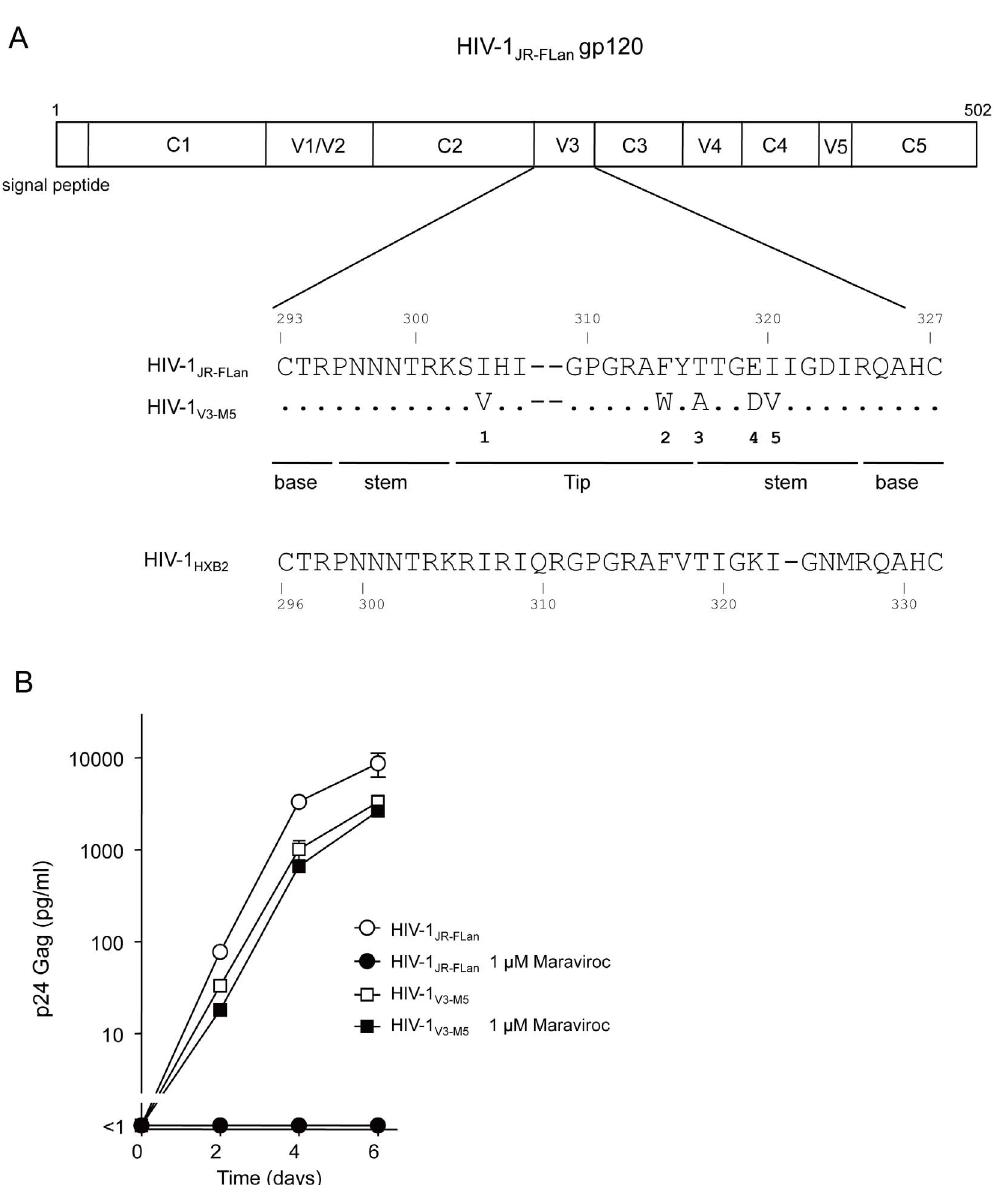
Figure 1. Noncompetitive resistant HIV-1 V3-M5 . (A) Five amino acid substitutions in the V3 loop of HIV-1 V3-M5 (I304V/F312W/T314A/E317D/ I318V). HIV-1 JR-FLan was created form HIV-1 JR-FL by incorporation of AflII and NheI. Incorporation of the NheI site led to amino acid substitutions Val 342 - Ile 343 to Ala 342 -Ser 343 . HIV-1 JR-FLan was used as the parental virus. (B) Replication kinetics of HIV-1 V3-M5 in the presence or absence of 1 m M maraviroc in PM1/CCR5 cells. PM1/CCR5 cells (1 6 10 5 ) were infected with 10 ng of p24 Gag for 3 h. Viral replication was monitored by measuring p24 Gag in the supernatant after infection. The analysis was repeated three times; the error bars represent the S.D. of three replicates from one representative experiment.